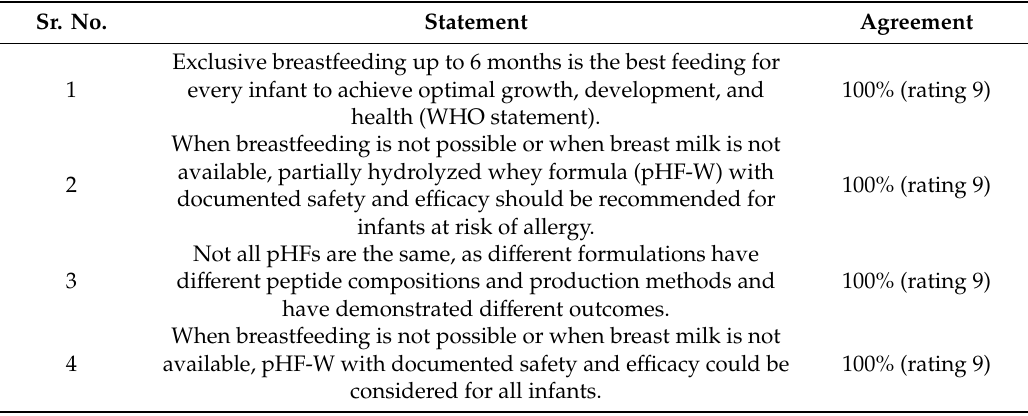
Figure 1. Middle-East Consensus algorithm for the prevention of allergy. BF: breastfeeding; CMF: cow milk protein; pHF: partially hydrolyzed formula. Table 2. Middle-East Consensus statements on the prevention of